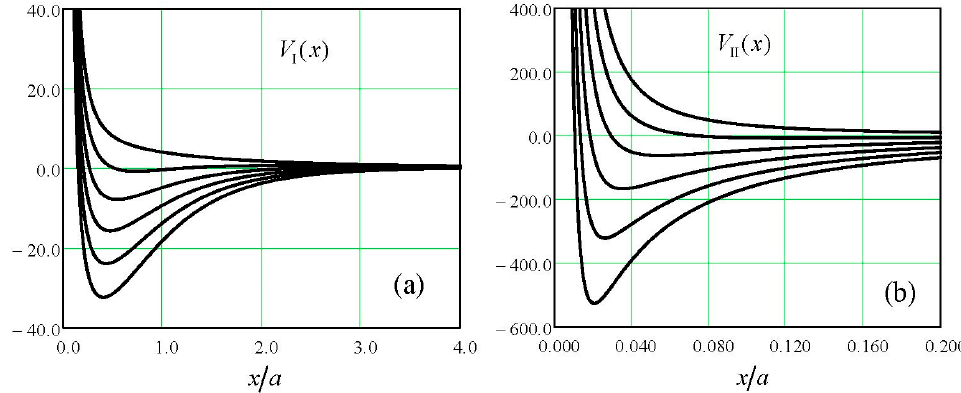
Figure 1. The two potential functions V I ( x ) (1a) and V II ( x ) (1b) (in units of A ) for several values of the associated parameters: ( a ) V I ( x ) with C = 5 A and several values of B , and ( b ) V II ( x ) with C = 2 A and several values of B .